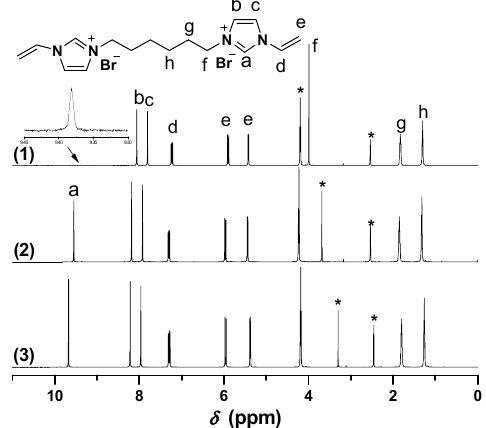
Figure 1. 1 H-NMR of [C 6 VIm]Br in different deuterium solvents. ((1) 0.6 mL DMSO- d 6 + 0.1 mL D 2 O, 30 min later; (2) DMSO- d 6 + 0.05 mL D 2 O, immediately; (3) 0.6 mL DMSO- d 6 ). * The peak is ascribed to the